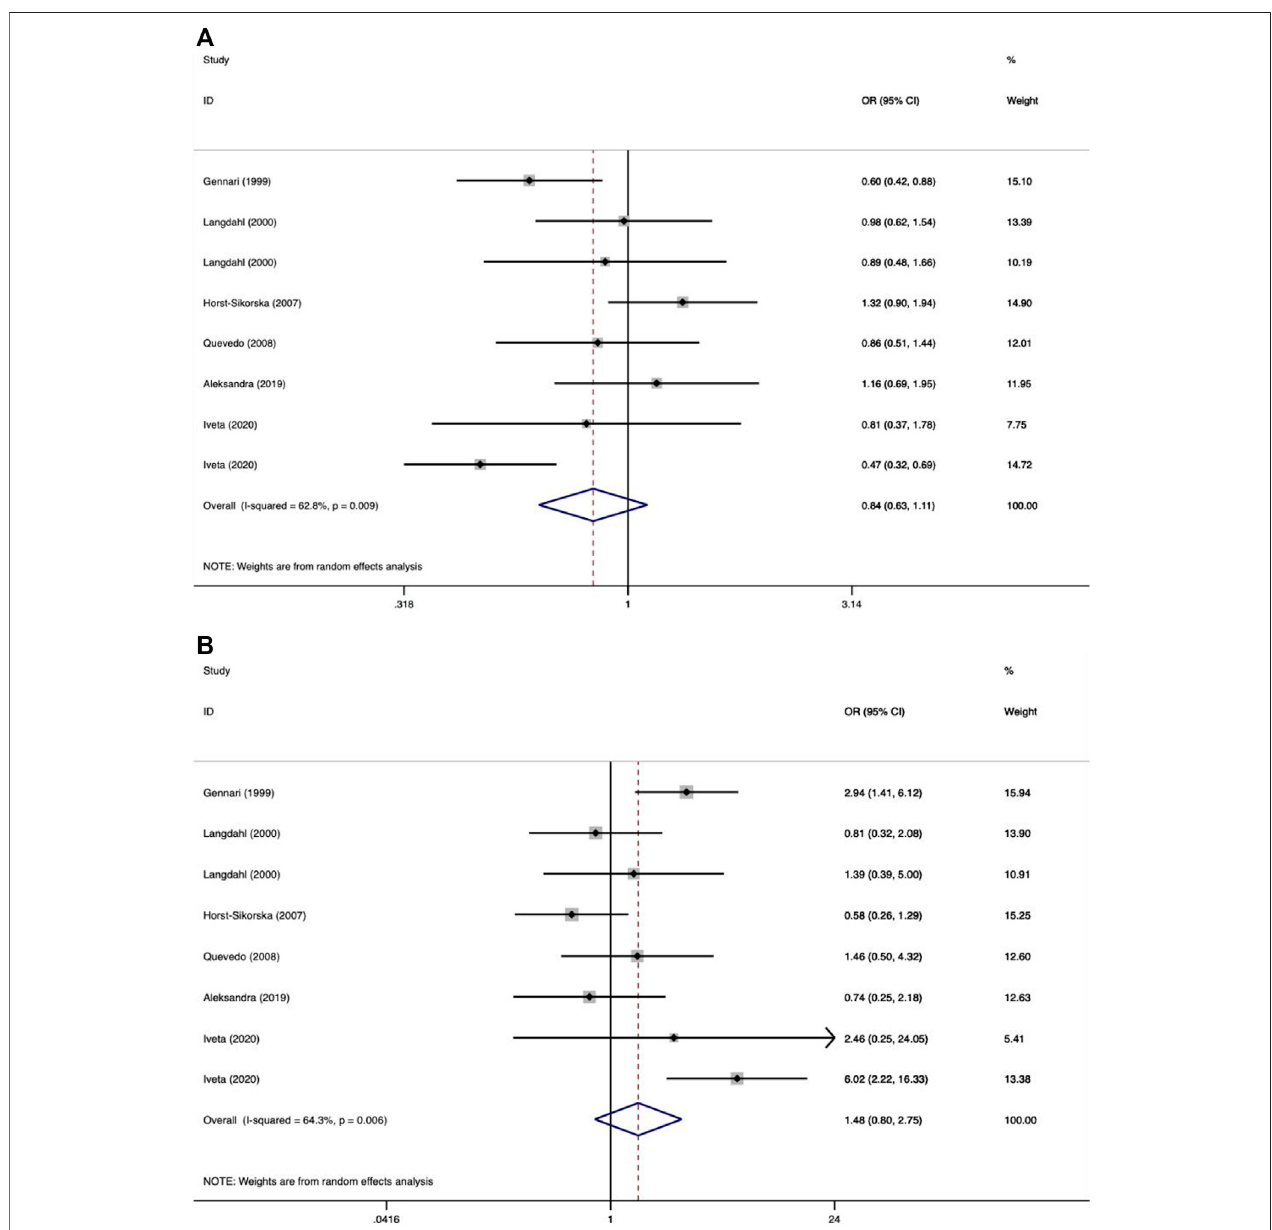
FIGURE5| Forest plotsofall selected studieson theassociationbetween VDRFokl polymorphismand theriskofosteoporotic fracture indifferent races [ (A) allele model, (B) additive model, (C) dominant model, and (D) recessive model].